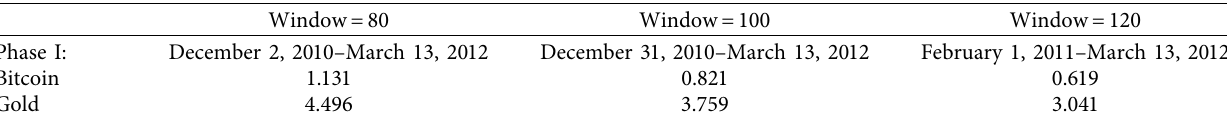
Table 5: Dynamic to spillover with different rolling